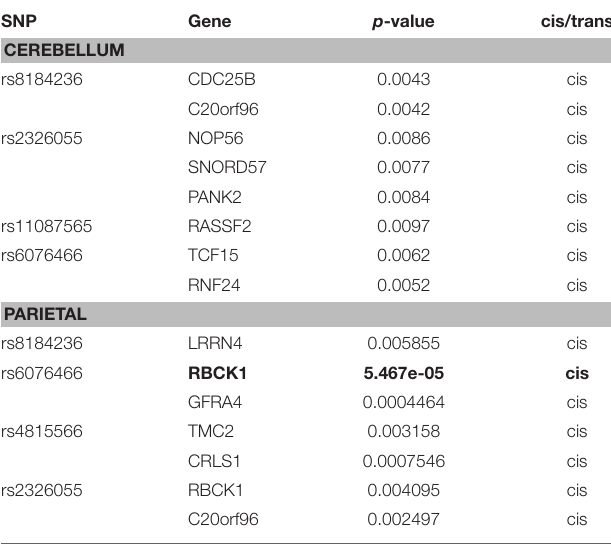
TABLE 4 | Significant SNPs from eQTL